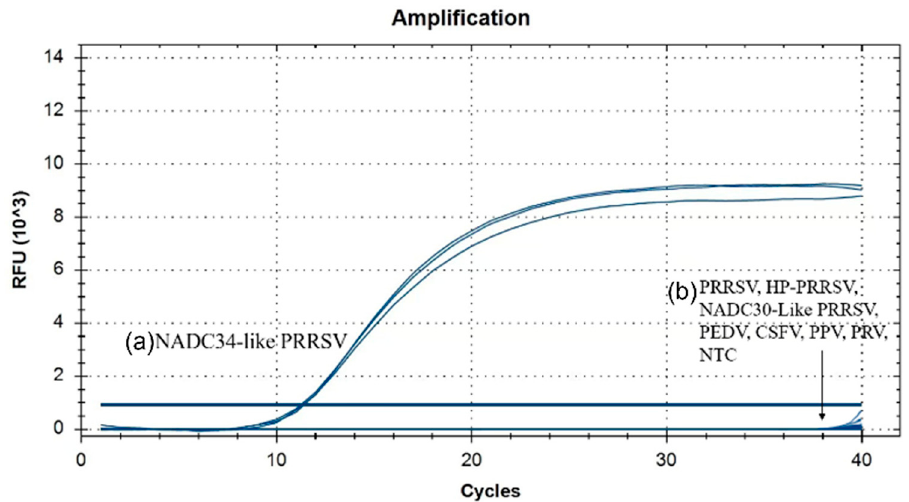
Figure 2. Specificity of NADC34-like PRRSV gene based on the qRT-PCR assay. ( a ) Represented the real-time RT-PCR amplification curve of NADC34-like PRRSV plasmid; ( b ) Represented the real-time RT-PCR amplification results of PRRSV, PRRSV, HP-PRRSV, NADC30-like PRRSV, PEDV, CSFV, PPV, PRV, and no-template control (NTC).